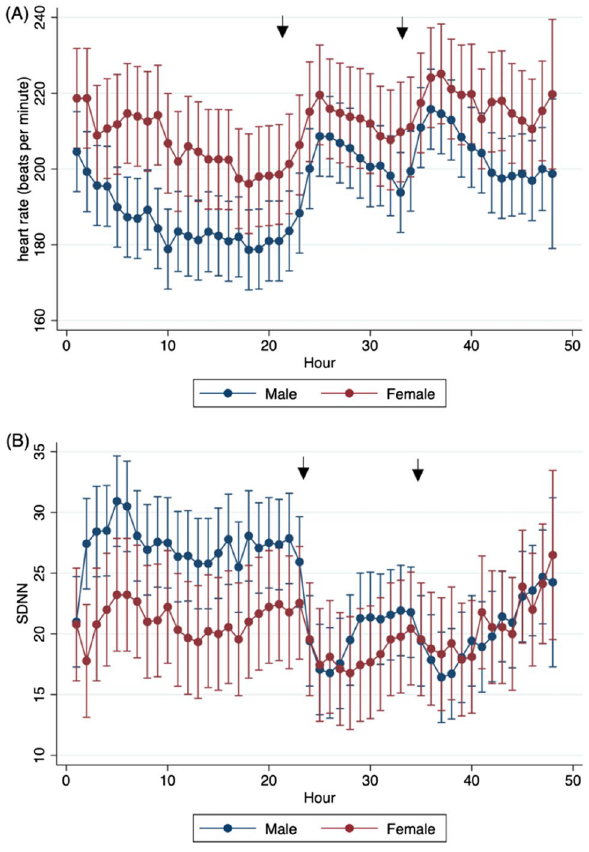
Figure 3. Heart rate and heart rate variability shown between male and female cats. ( A ) Mean heart rate (HR) plotted by hour for the entire AECG recordings separated by sex. ( B ) Standard deviation of NN intervals (SDNN) plotted by hour for the entire AECG recordings separated by sex. Arrows indicate when terbutaline was